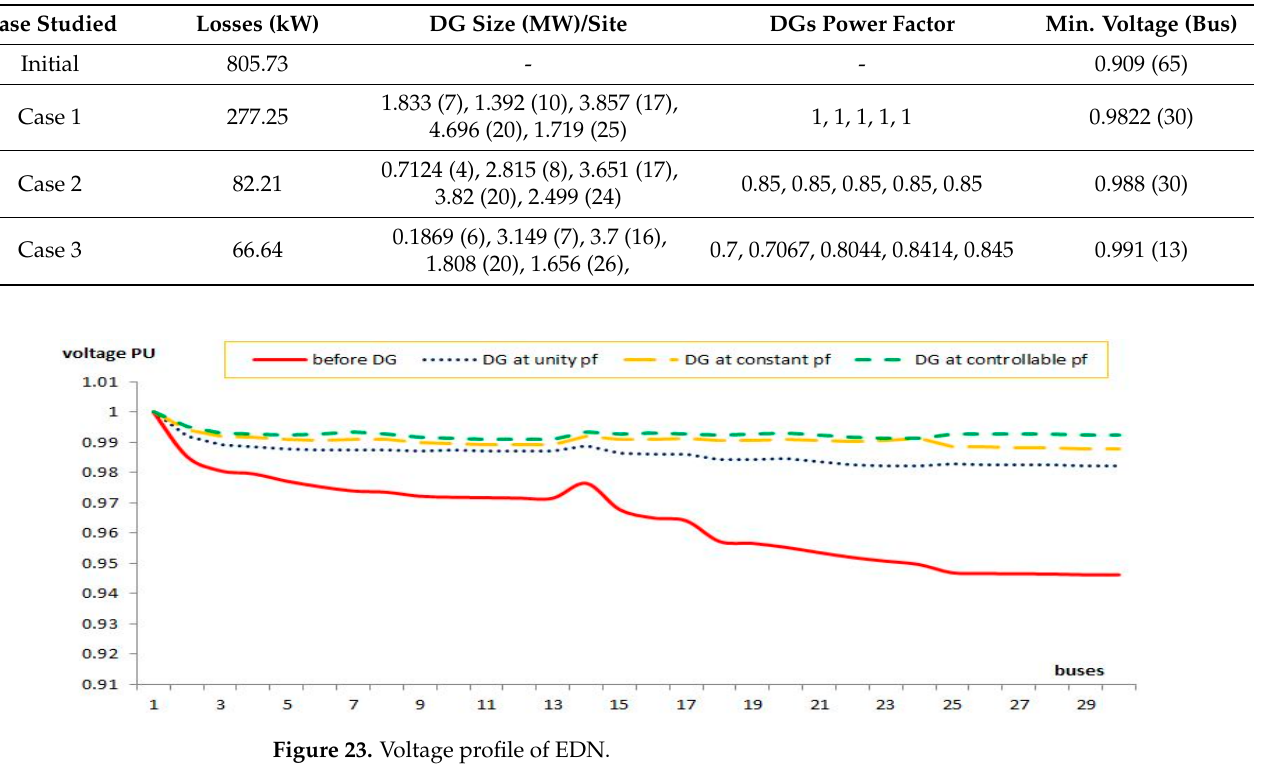
Table 2. Optimal allocation of DGs using GWO.